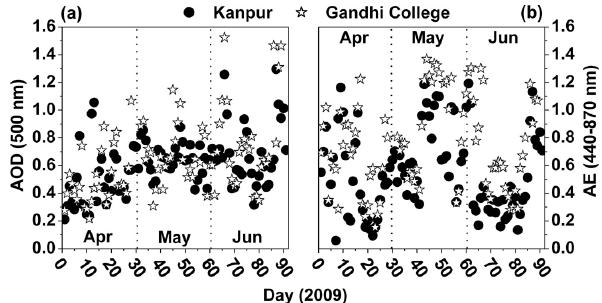
Fig. 3. Daily mean variations in (a) AOD at 500nm and (b) AE at 440–870nm at Kanpur and Gandhi College during April to June